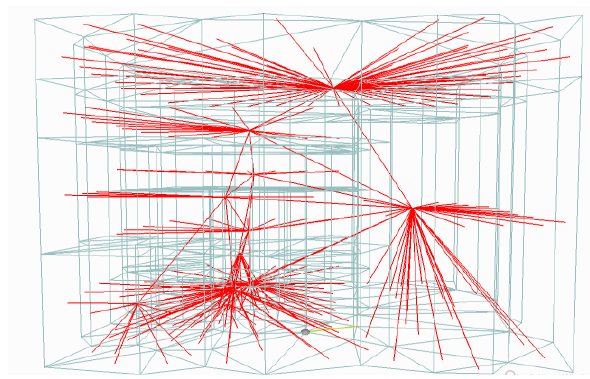
Fig. 14. The result of simply transform the 3D model into DHE